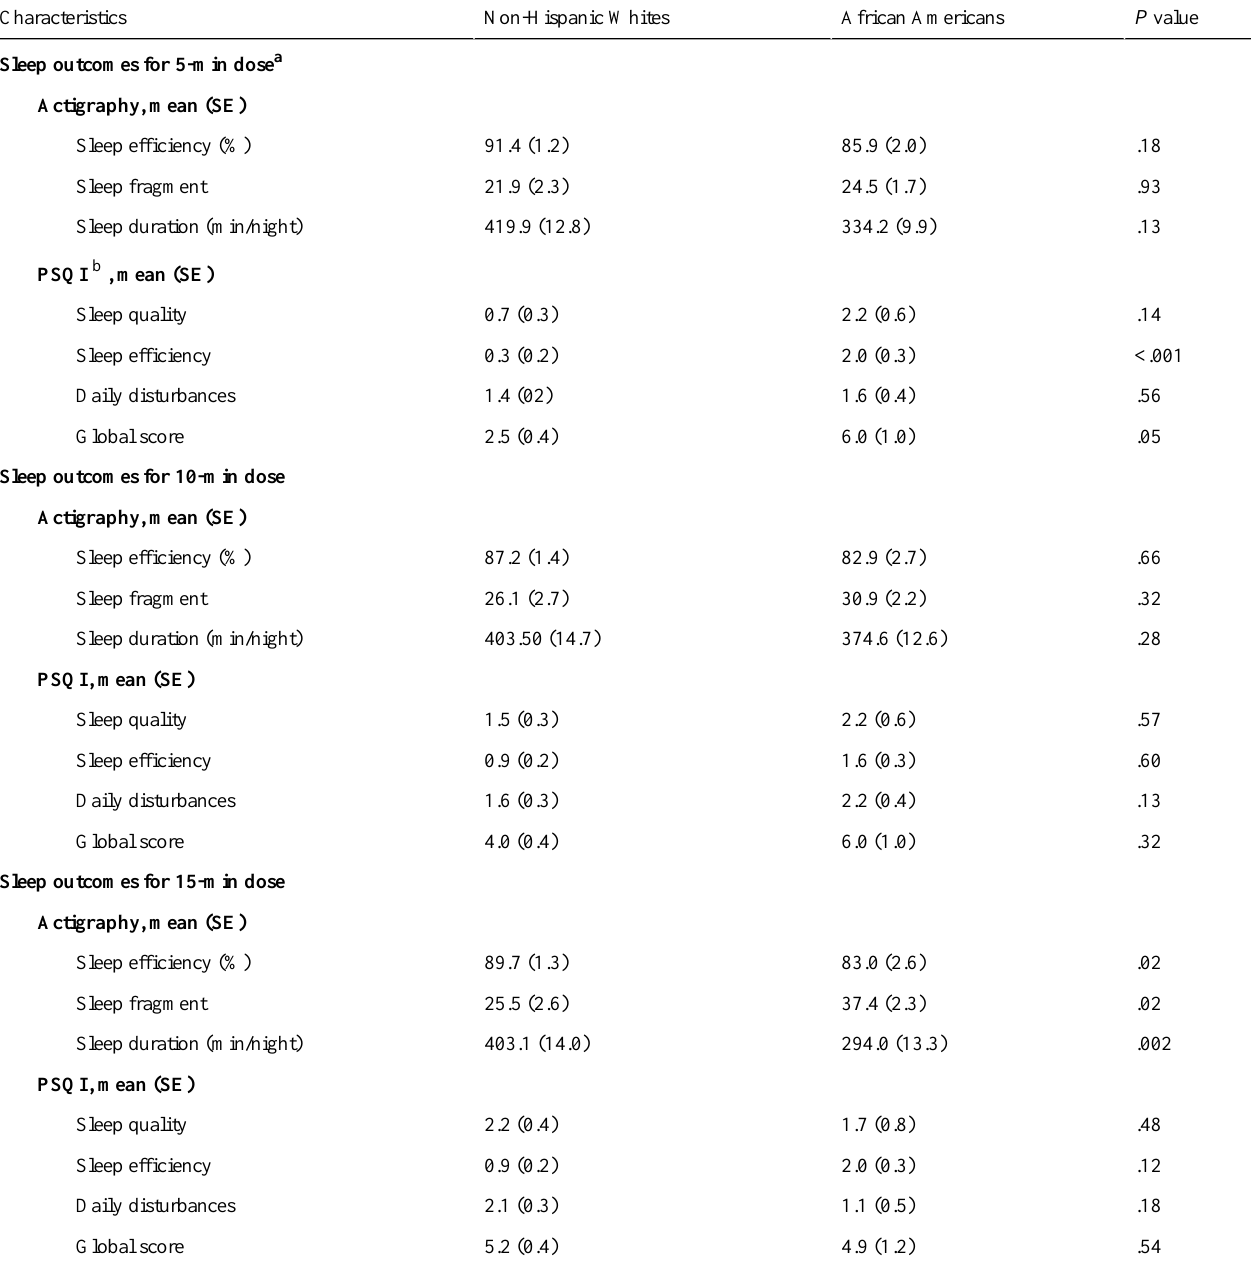
Table 4. Effect of ethnicity differences and the dosage of Tension Tamer app on sleep measures at 6-month follow-upa. Values represent the adjusted means and